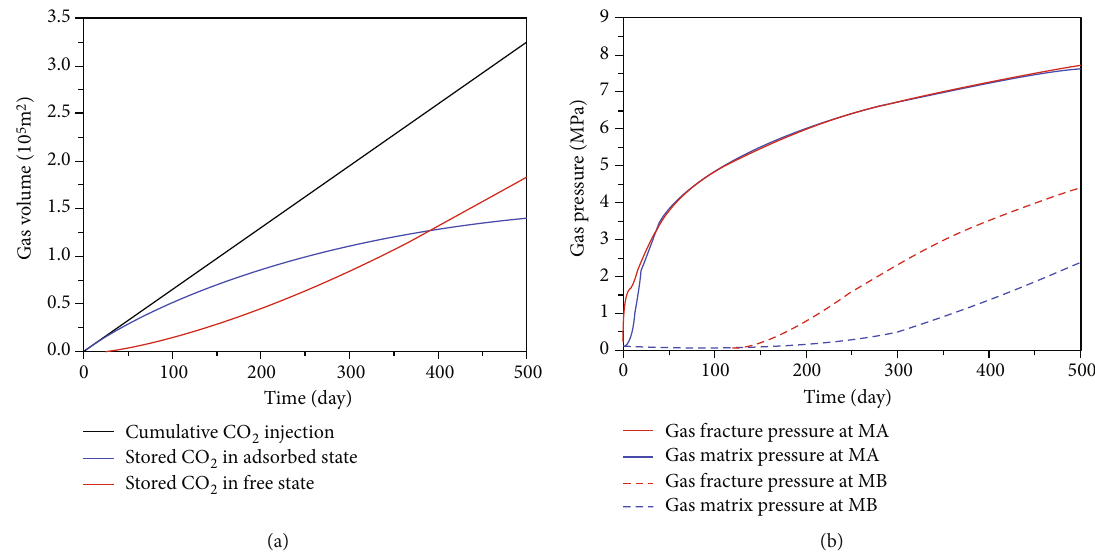
Figure 9: The variation of (a) cumulative CO injection and (b) gas pressure of matrix and fracture at MA and MB during 500 days of injection. 2